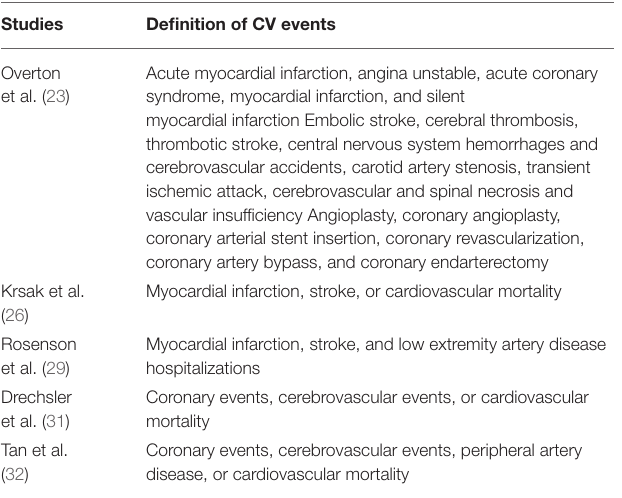
TABLE 3 | Definition of CV events among the five included